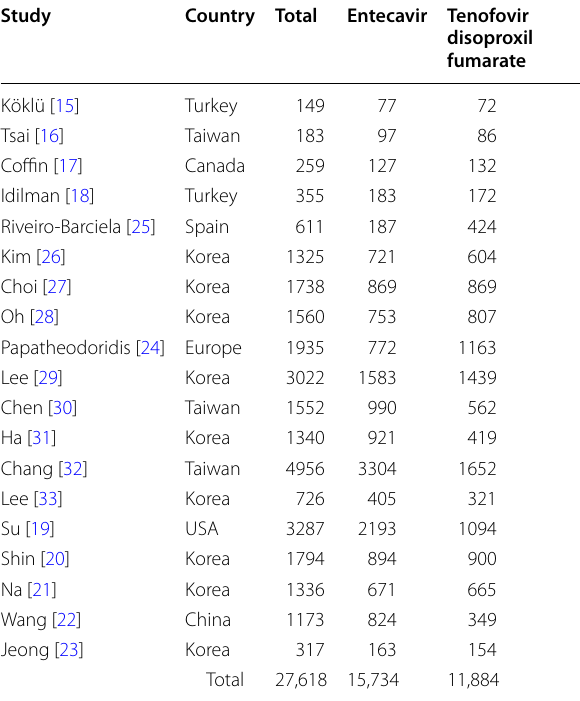
Table 2 Characteristics of the selected studies for the meta- analysis